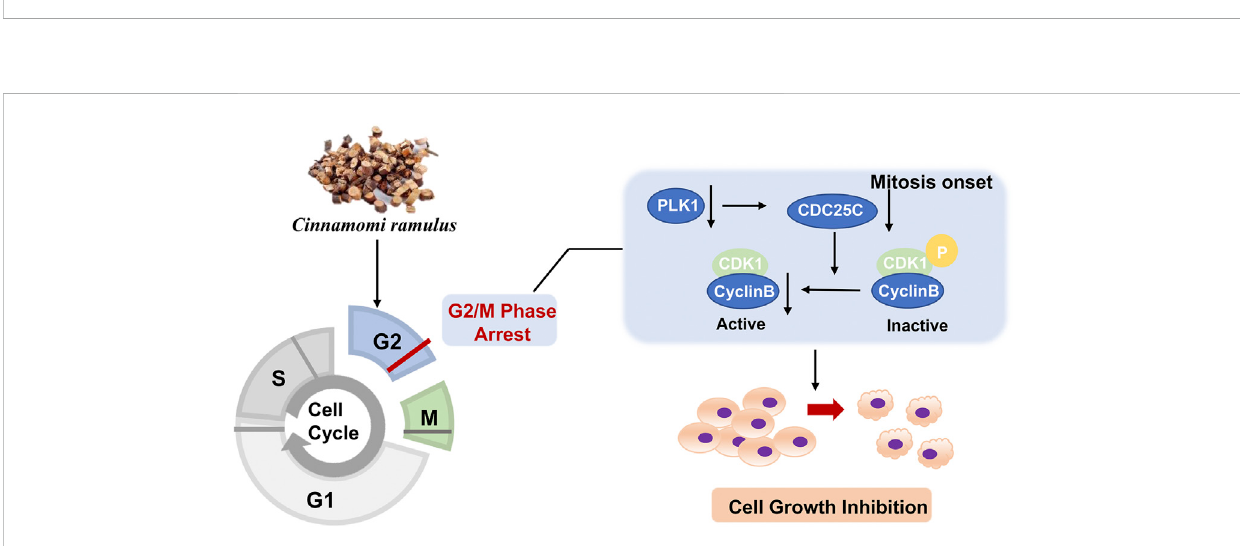
FIGURE 11 The potential mechanism of CR inhibiting cell